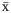
(a) A plot showing null hypothesis distribution generated using Monte Carlo Simulation (blue density and scatter plots) and bootstrap based mean and confidence interval estimation of the prediction error encountered by the tsp model (red density and scatter plots). The x-axis shows the number of iterations/replicates while the y-axis shows the prediction error. Dark blue lines, both in the density plots and scatter plots represents estimated mean of the null hypothesis (x- [Ho]). Full red line is the mean prediction error (x- [boostrap]) as estimated by the bootstrap analysis while the dashed red lines are the corresponding 95% Confidence Intervals (95% CI [bootstrap]). The black line indicates the empirical prediction error (EPE) obtained in the validation set analysis. (b) A Plot of the statistical significance and confidence interval of the prediction analysis of the SVM model (details of the labels are as described in Fig 4a).